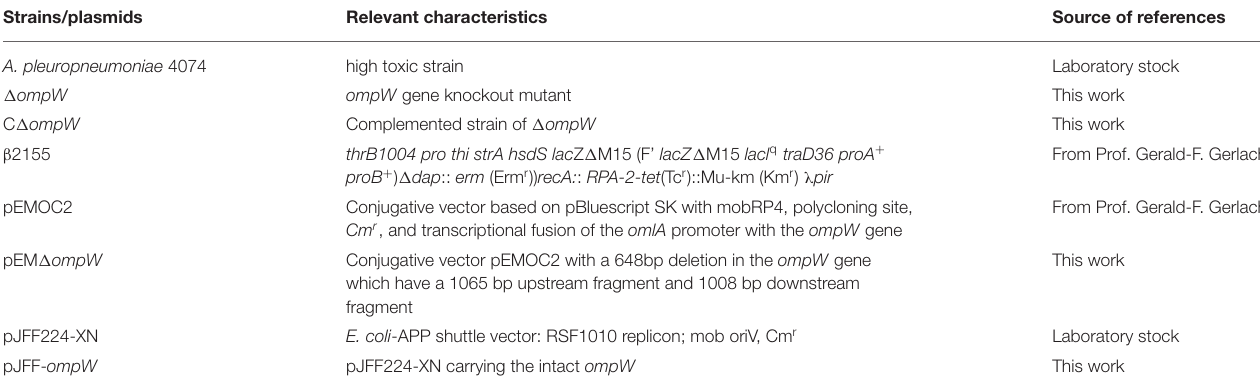
TABLE 1 | Bacterial strains and plasmids used in this